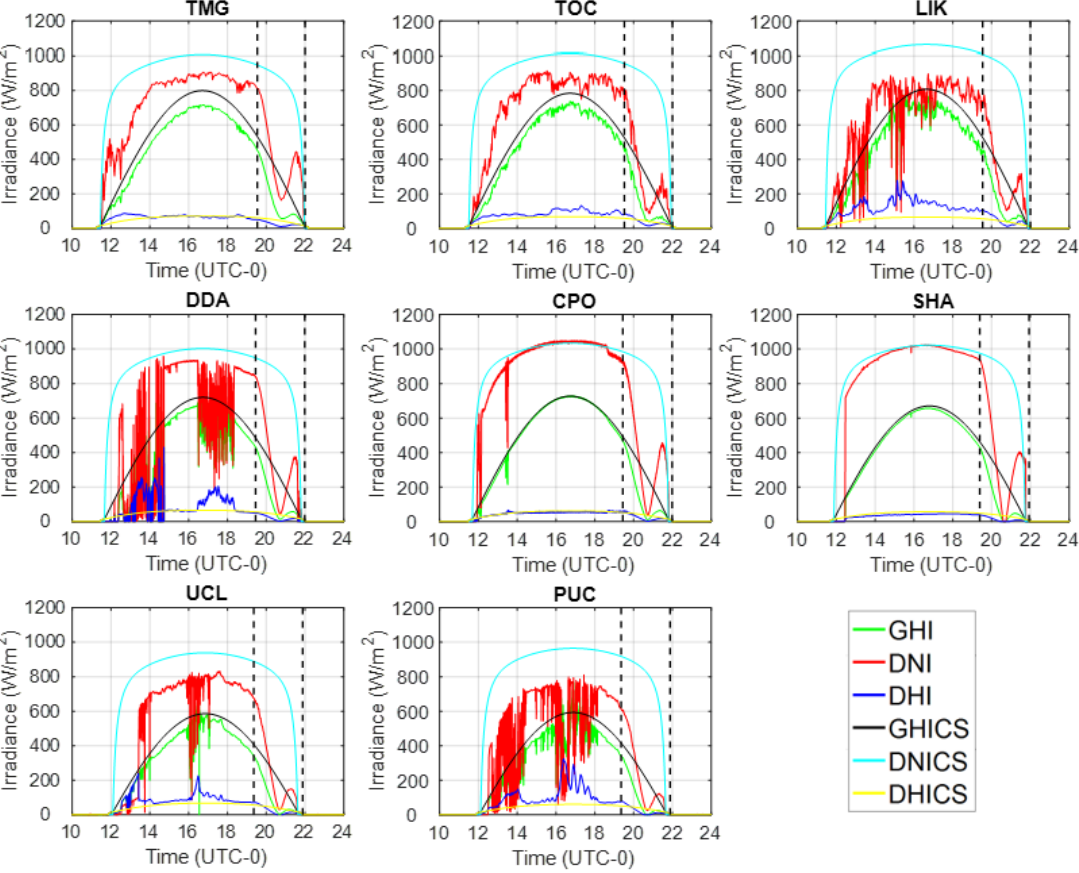
Figure 9. Irradiance time series for each measurement station for 2 July 2019. Vertical dashed lines mark the beginning and end of the eclipse according to astronomical algorithm. With respect to the meteorological variables, all stations exhibited a similar pattern regarding temperature and relative humidity, while wind speed and direction were quite different, as shown in Figure 10. As the day progressed and irradiance increases, so does temperature, while relative humidity decreases. However, since the start of the eclipse, an early sunset effect was observed in all stations, as temperature decreased and, correspond- ingly, relative humidity increased. Even though wind speed and direction behavior was different among the different stations, in all cases but DDA and TMG, wind speed signif- icantly dropped as the eclipse progressed, when compared to pre-eclipse values.